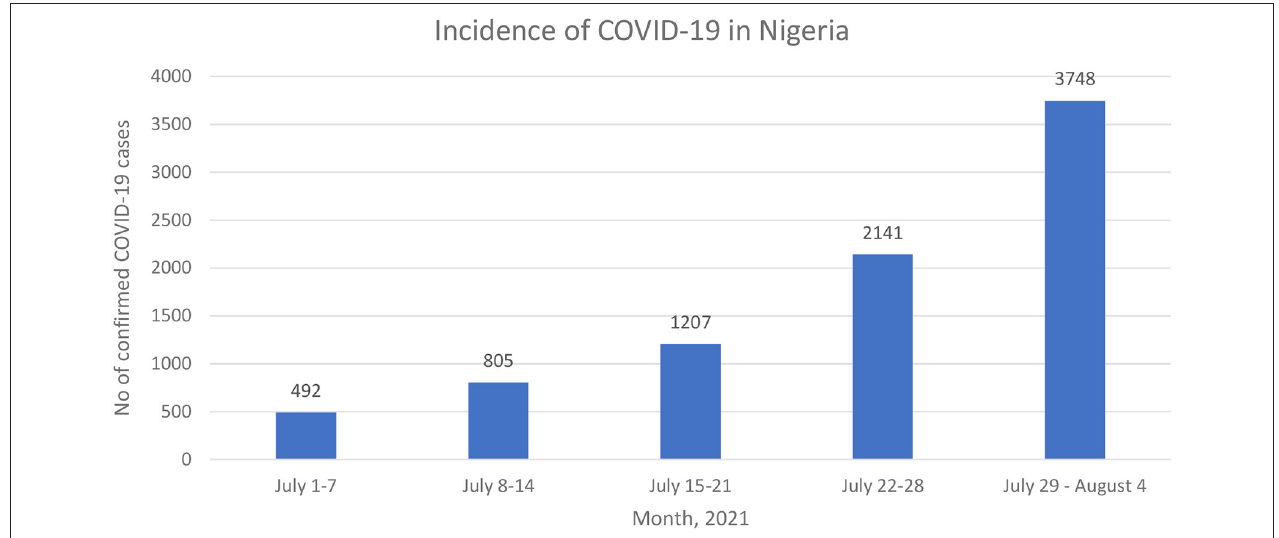
FIGURE 1 | Weekly incidence of confirmed COVID-19 incidence in Nigeria (3).